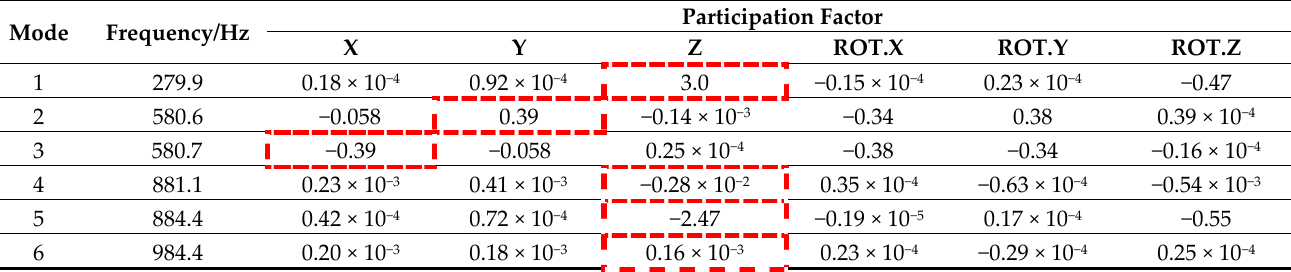
Table 4. Modal participation factor of the full tubular pump in each mode.